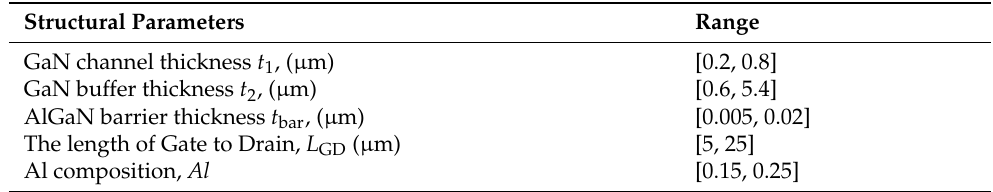
Table 2. AlGaN/GaN HEMTs structural parameters and their variation ranges. Structural